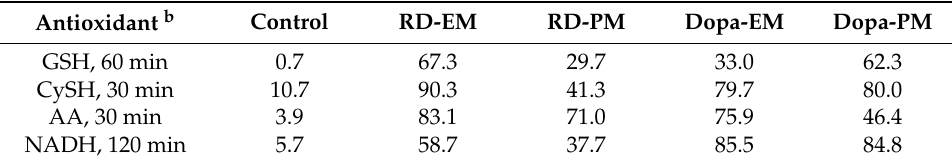
Figure 4. Tyrosinase-catalyzed oxidation of RD giving rise to RD-eumelanin (RD-EM). Our previous study [9] showed that the immediate product is RD-quinone, which undergoes the addition of a water molecule and is oxidized to form RD-hydroxy- p -quinone. RD-hydroxy- p -quinone gradually dimerizes to form RD-EM [9,11,12]. The oxidized form of RD-EM is able to oxidize thiols (R-SH), ascorbic acid (AA) and NADH to disulfides (RS-SR), dehydroascorbic acid (DeAA) and NAD + , respectively, while the reduced form of RD-EM is able to reduce molecular oxygen producing superoxide radicals. It is likely that RD-EM is a mixture of dimers and tetramers [33]. Our latest study showed that the pro-oxidant activity of RD-EM is enhanced by UVA radiation [34]. Table 2. Oxidation of various antioxidants by synthetic melanin a .